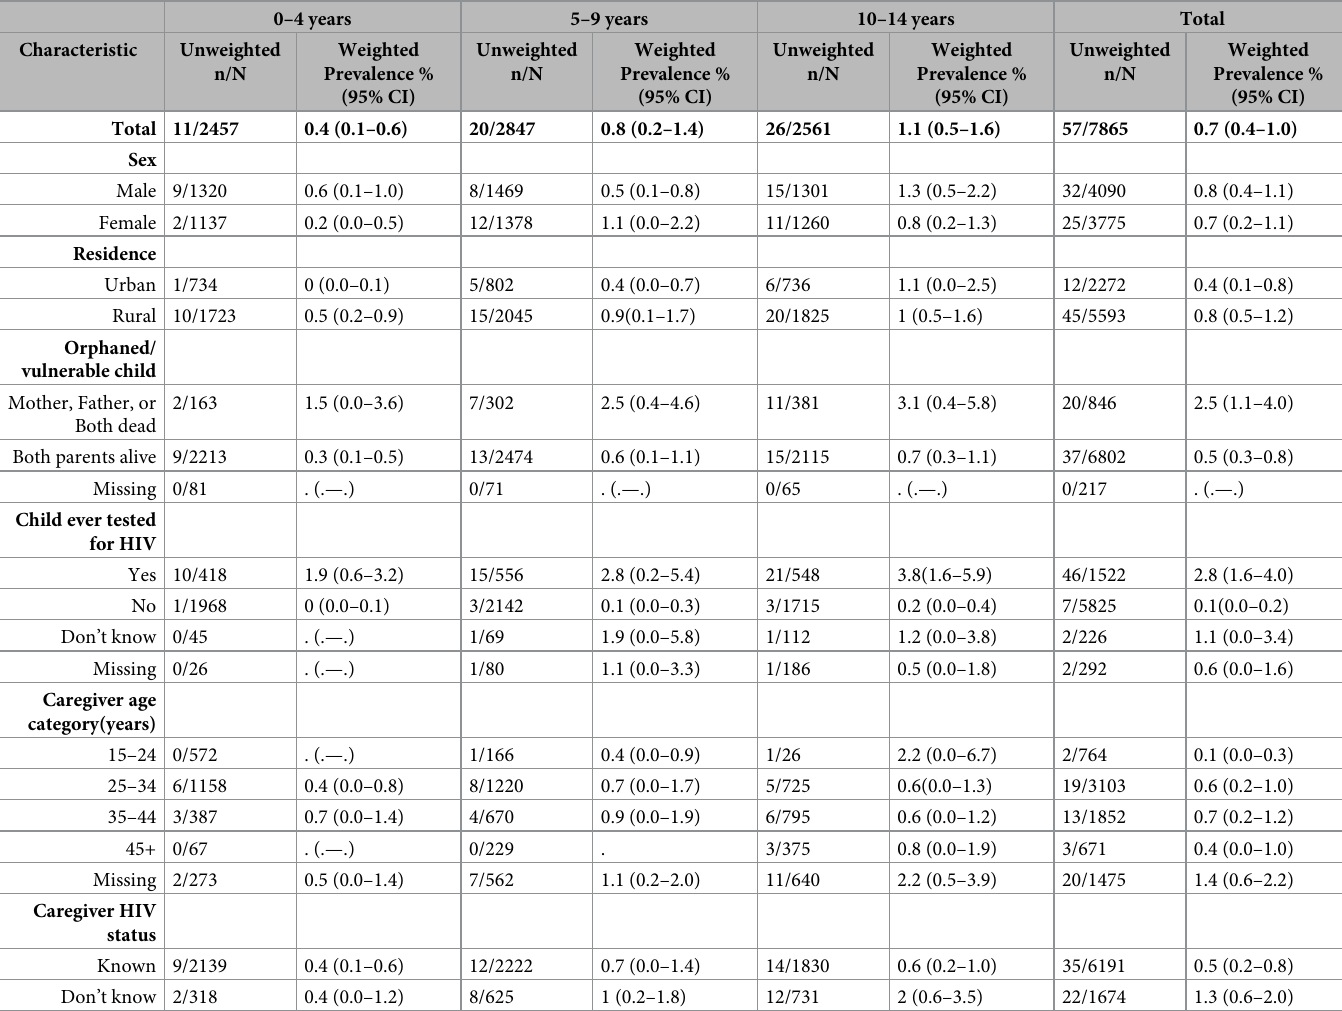
Table 2. HIV prevalence among children aged 0–14 years by age group, KENPHIA